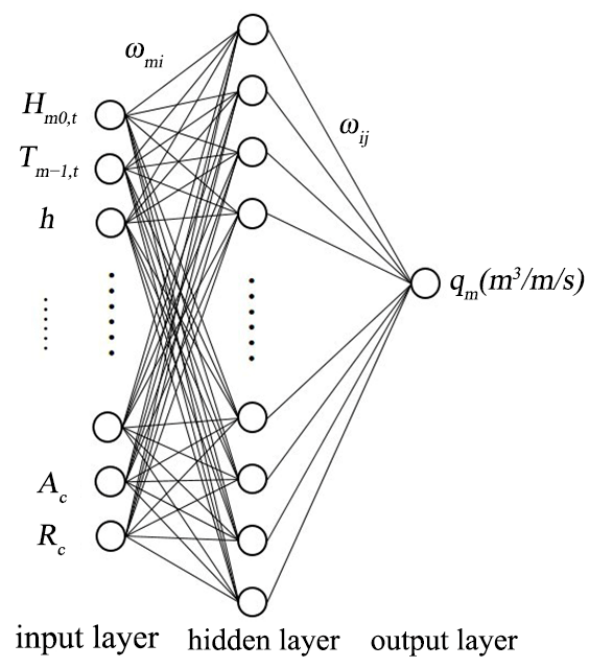
Figure 7. ANN model for estimating overtopping.